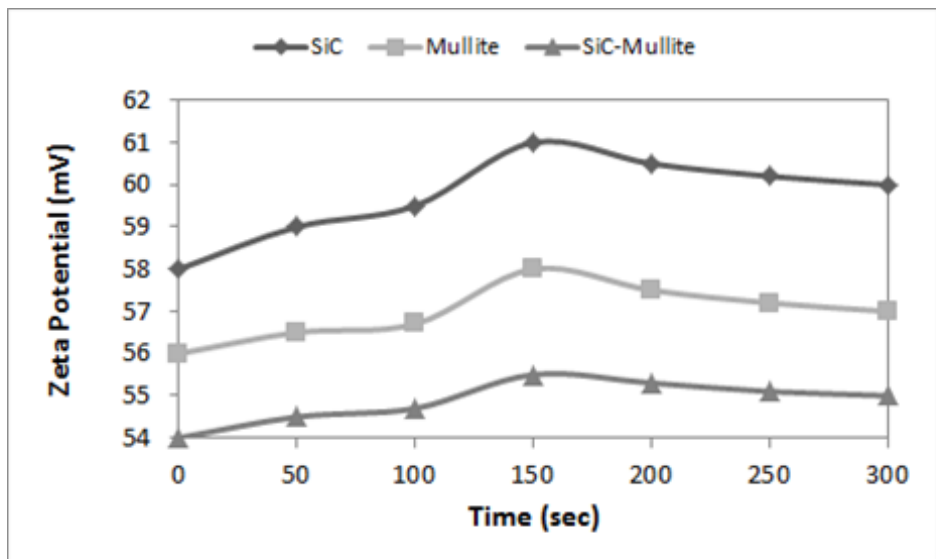
Fig. 3. Zeta Potential vs. time of coating for various